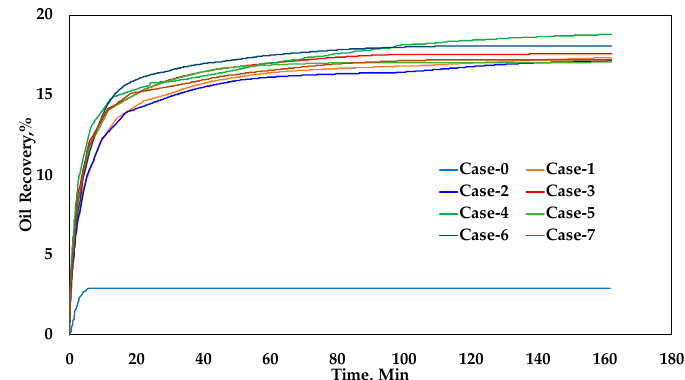
Figure 8. The comparison of oil recovery in fracture and no-fracture conditions.